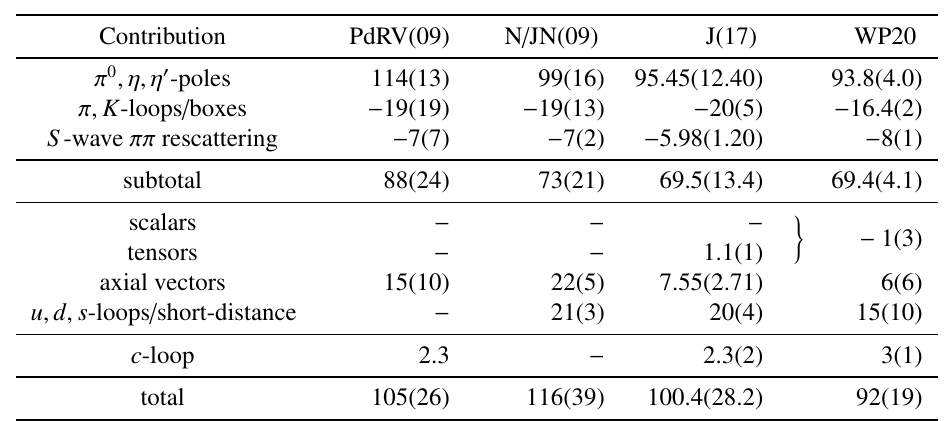
Table 1. Estimates for the various contributions to HLbL scattering from WP20 [6], PdRV(09)